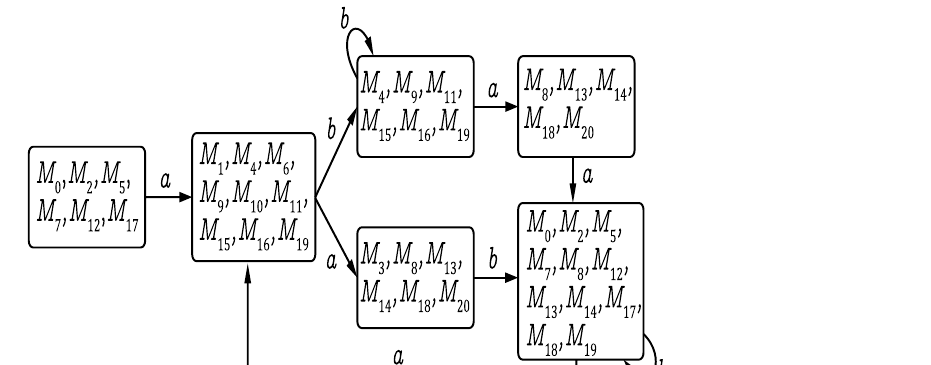
Figure 2. RG of the LPN in Fig. 1.